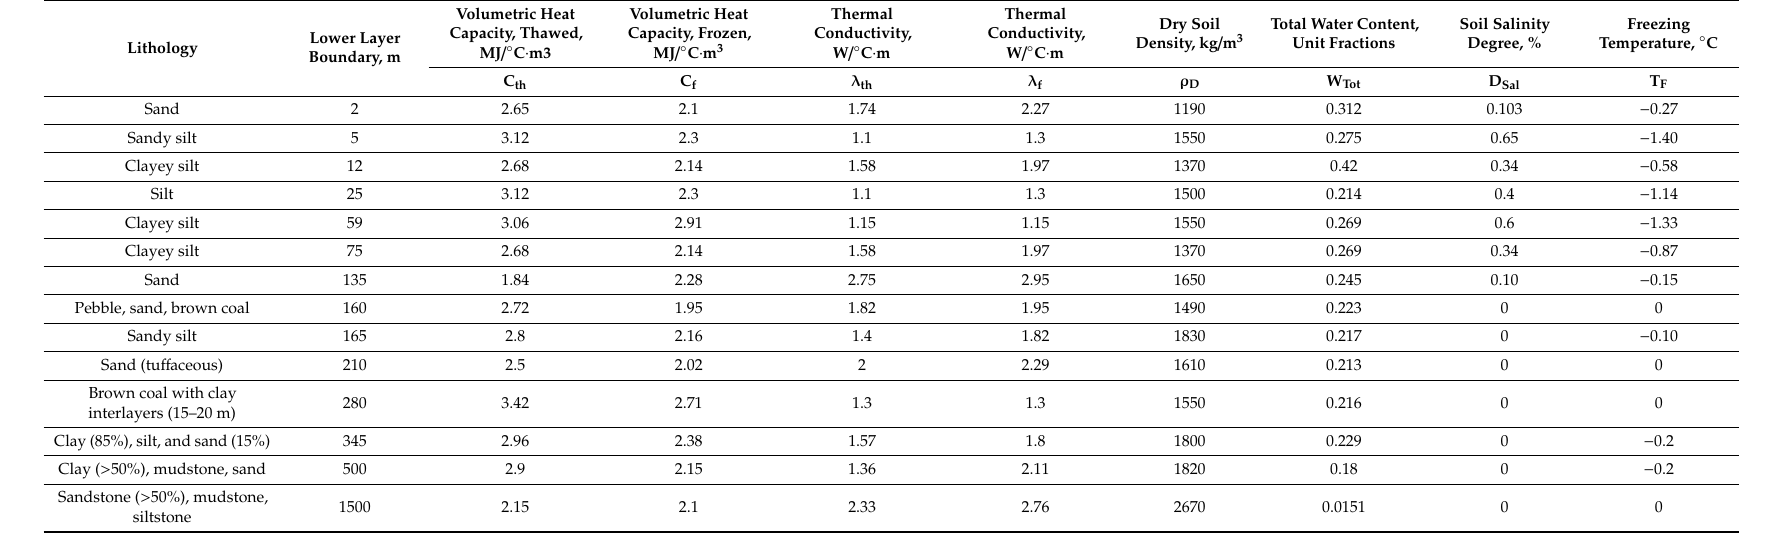
Table A1. Physical and thermophysical properties adopted in the numerical